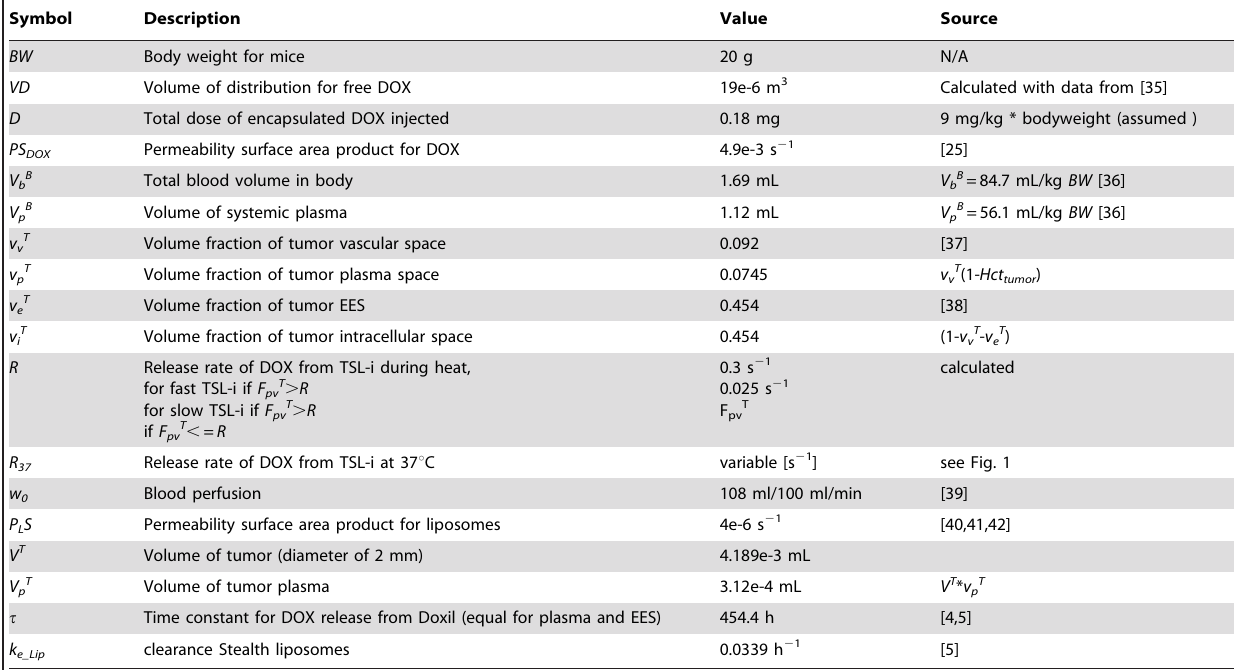
Table 1. Primary model parameters.